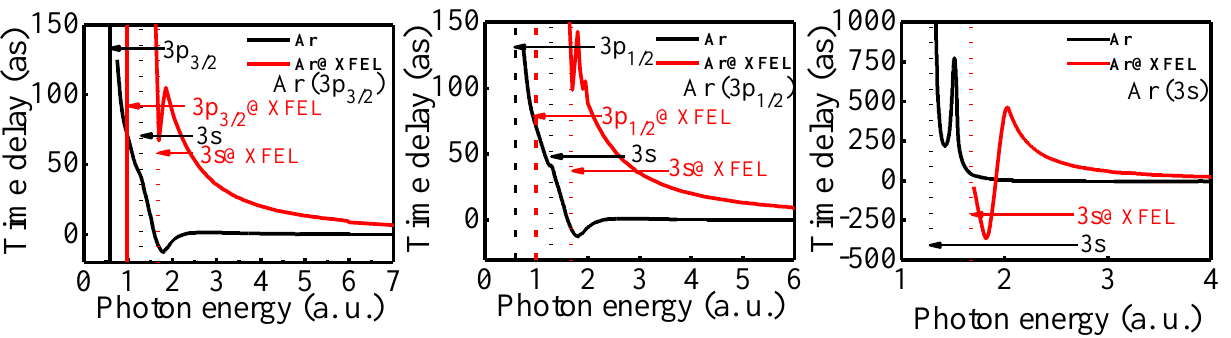
Figure 9. Time delay (τ) of 3p 3/2 (Left), 3p 1/2 (Middle), and 3s (Right) subshells of Ar (black) and Ar@XFEL (red). Solid, dashed, and dotted vertical lines represent the threshold for 3p 3/2 , 3p 1/2 , and 3s thresholds of free (black) and confined atom (red), respectively.